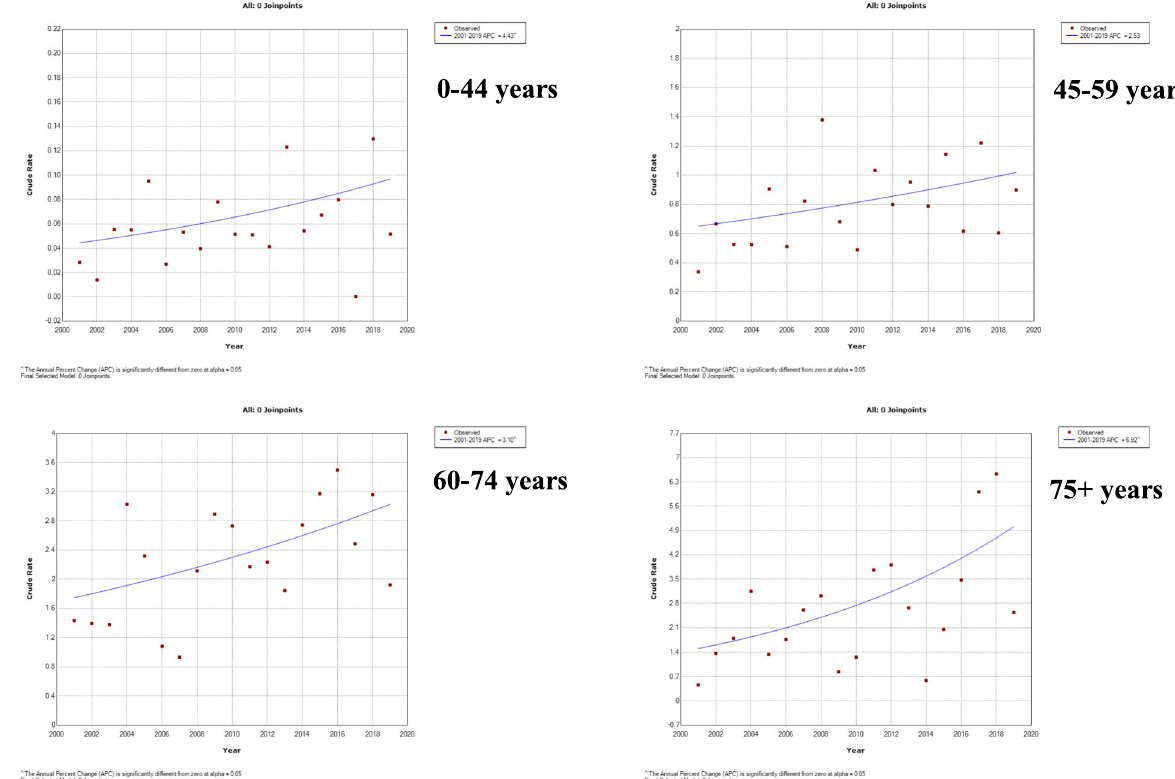
Fig. 5 Joinpoint regression analysis of age-categorised trends in the incidence of laryngeal cancer among females from 2001 to 2019 in Sri